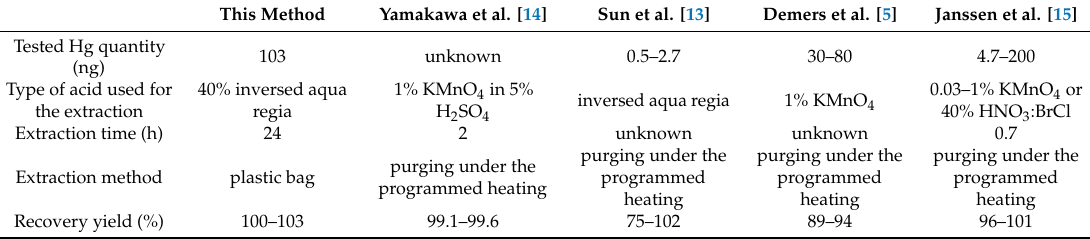
Table 3. Comparison of acid extraction methods for gaseous elemental